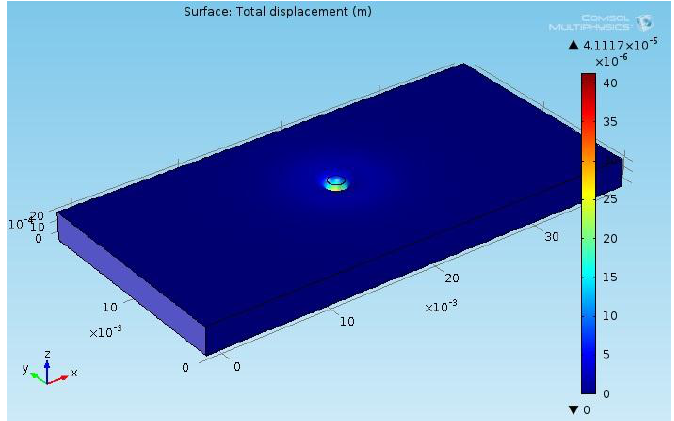
Figure 9. An example of FEM simulation results (total displacement is shown). Parameters: F 3 = 2 N, R = 10 mm, E = 16 MPa, ν = 0.5, r T = 1 mm. Elastomer size: thickness h = 2.5 mm, length l = 40 mm, width b = 20 mm.